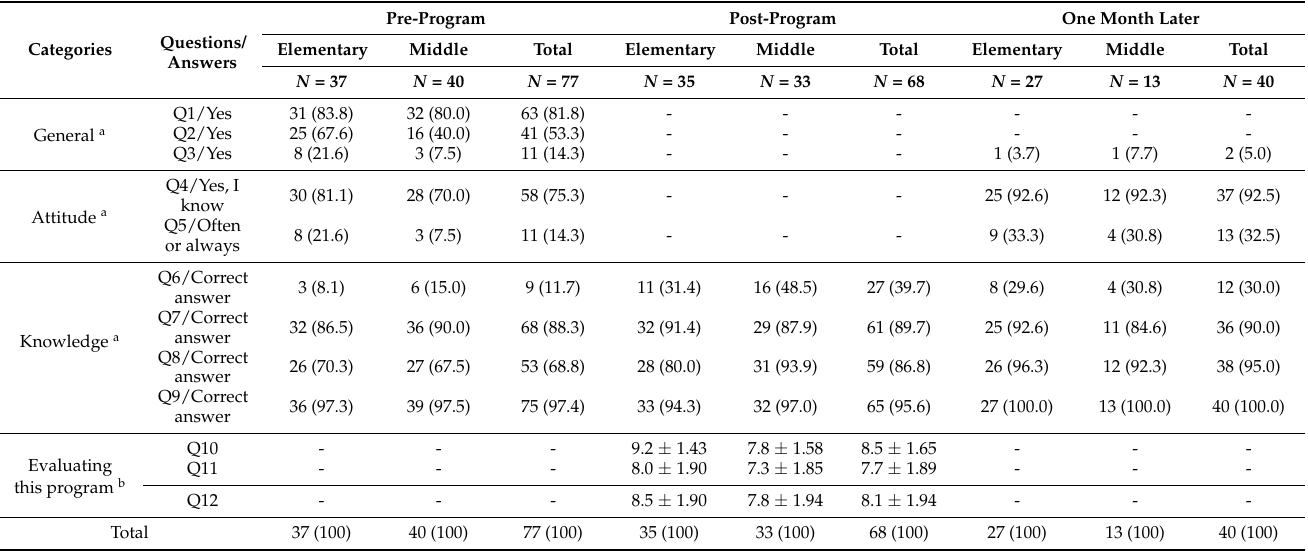
Table 2. Responses: Before the program, immediately after the program, and one month